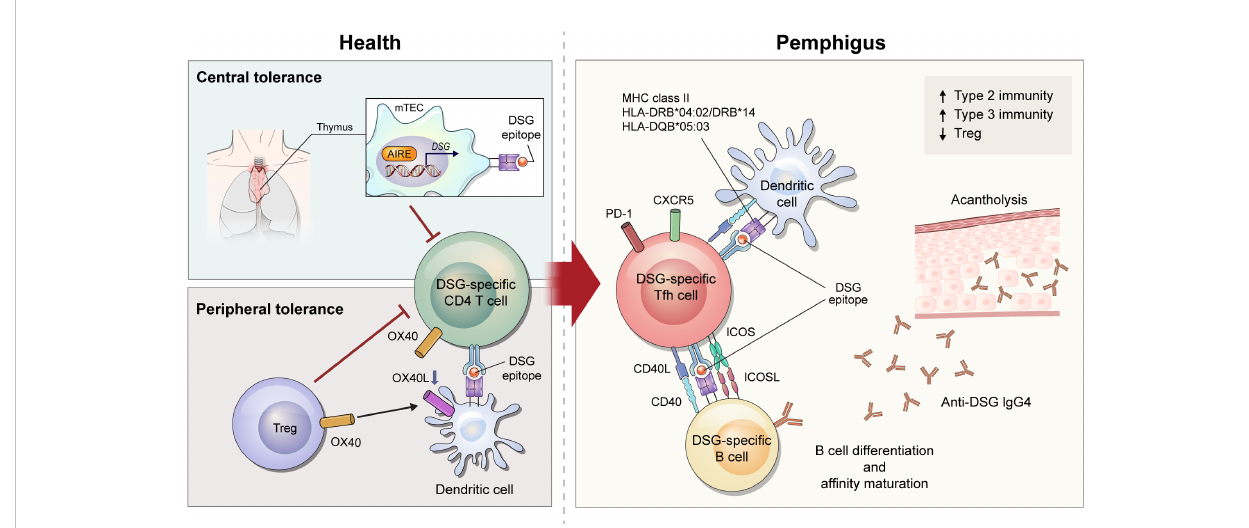
FIGURE 1 Schematic overview of immune mechanism of desmoglein (DSG)-speci fi c CD4 + T cells in pemphigus. After recognizing DSG epitope expressed on major histocompatibility complex class II from medullary thymic epithelial cells under the control of AIRE, DSG-speci fi c T cells undergo deletion in the thymus. When DSG-speci fi c T cells escape from central tolerance, Tregs control tolerance in peripheral regions via OX40L-OX40 signaling. In a diseased state of pemphigus, tolerance is broken and DSG-speci fi c CD4 + T cells become pathogenic. Of DSG-speci fi c CD4 + T cells, ICOS + Tfh cells interact with DSG-speci fi c B cells to provide stimulatory signals including CD40L-CD40 interaction and cytokines. These signals lead to B-cell activation and proliferation, differentiation into plasma cells, and production of pathogenic DSG-speci fi c IgG antibodies that induce acantholytic blister by loss of cell-cell adhesion in